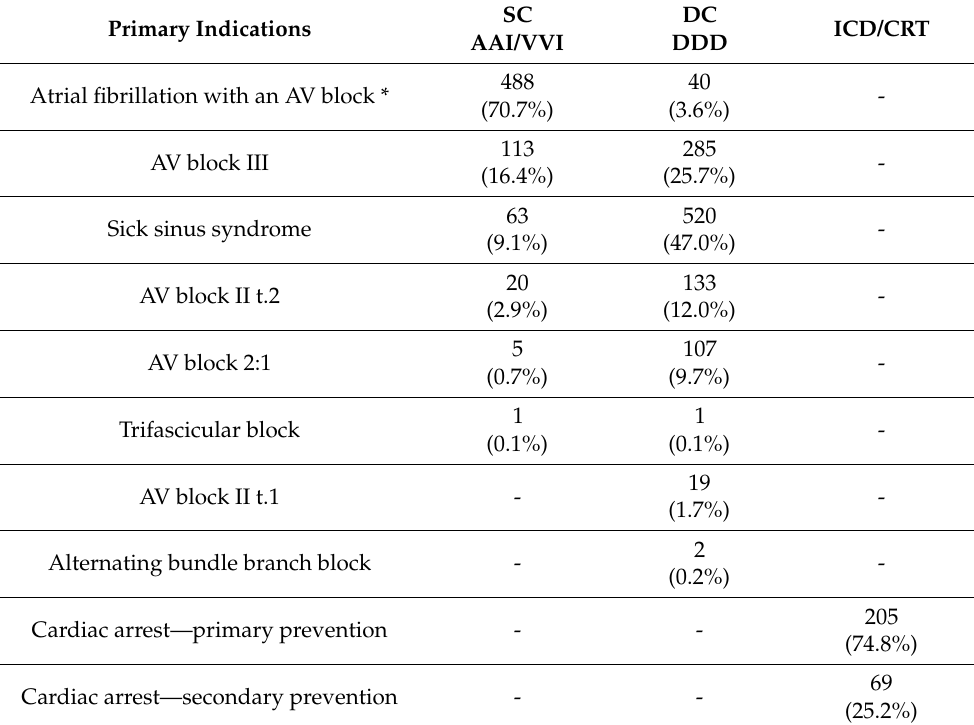
Table 2. Primary indications for device implantation (data presented as numbers and